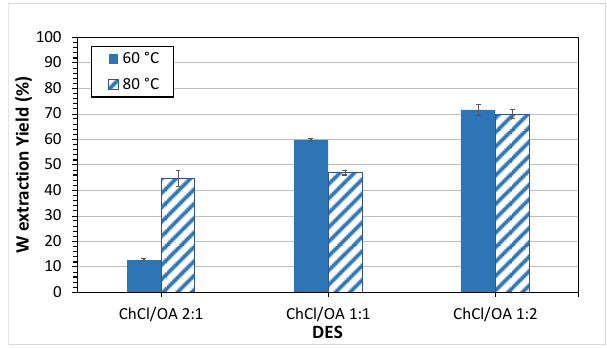
Figure 3. Effect of T on W ext. yield (L/S 10, time 24 h).